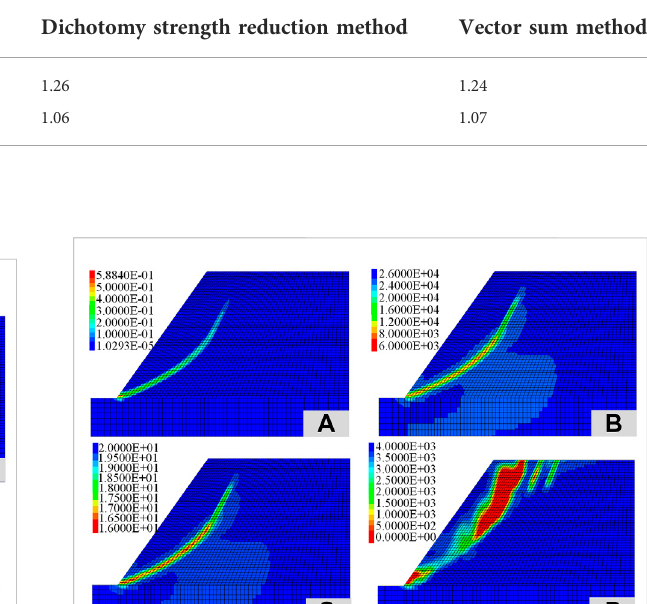
FIGURE 9 Static/dynamic slope response based on the elastoplastic model. (A – D) Maximum shear strain increment in the static state (A) , maximum shear strain increment in the dynamic state (B) , algebraic sum of the sliding force vector and anti-sliding force vector (C) , and dynamic time history safety factor (D) .